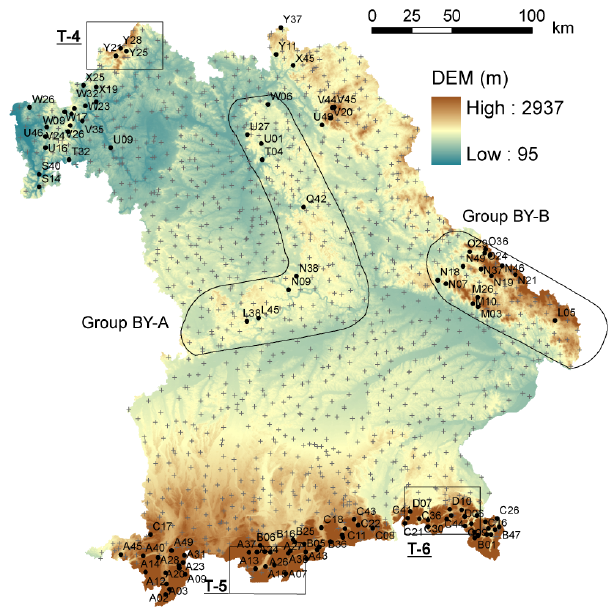
Fig. 6. Valley (solid circle) with station numbers and non-valley (cross) stations in BY (the rectangles indicate the location of the selected triplets, and the irregular shapes indicate the location of the